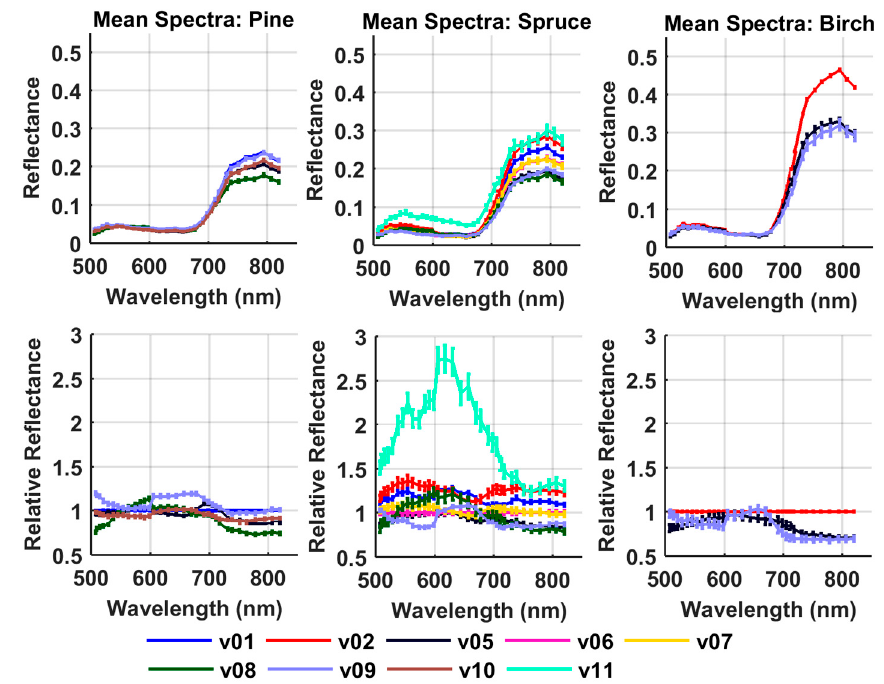
Figure 9. Mean spectra of different species at different test sites (top row) and their relative differences (bottom row). In the relative differences, Pine spectra have been normalized to test site v01, Spruce to v06, and Birch to v02. The Pine and Birch spectra normalized to areas which had most tree samples. Spruces were normalized to area v06 which was the spectral reference area in this study. The error bars present the standard error.